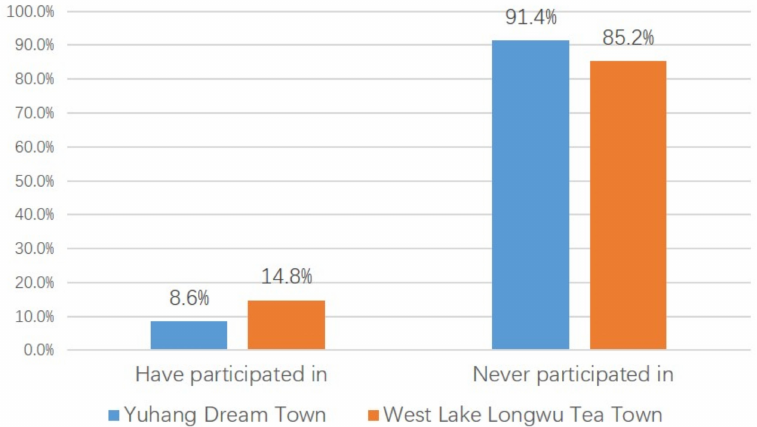
Figure 23. The proportion of respondents who have participated in discussion activities on the planning and construction of the local CT practice (source: authors).